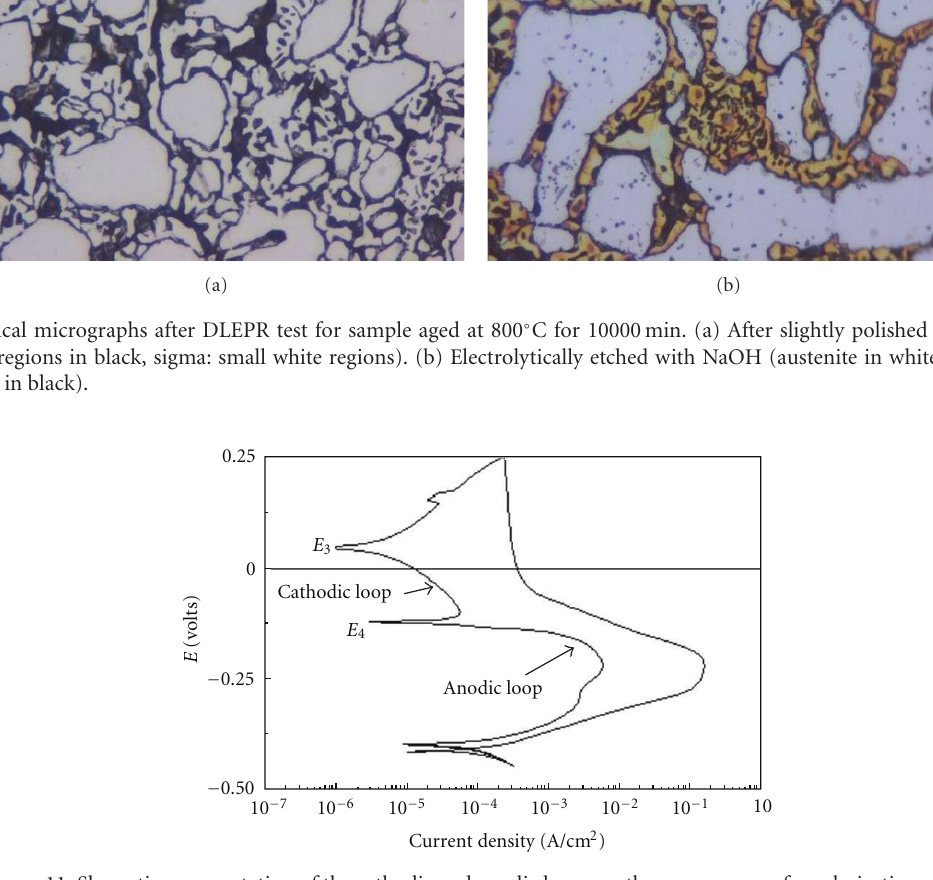
Figure 11: Shematic representation of the cathodic and anodic loops on the reverse scan of a polarization